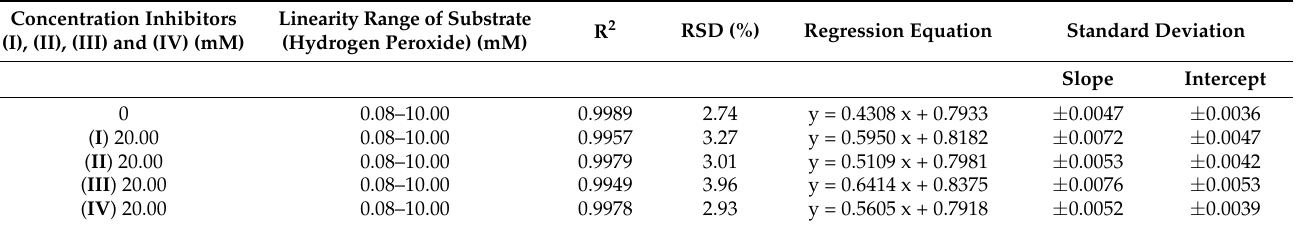
Figure 2. Representative electrophoregrams of investigated compounds in the presence of (I), (II), (III) and (IV) CAT inhibitors at the concentration of 20.00 mM, hydrogen peroxide at the concen- tration of 10 mM and (1) 20.00 mM of guaiacol (GCOL), (2) tetraguaiacol (TGCOL), (3) catalase (CAT). ( A ): (1) 11.71 mM of GCOL, (2) 8.29 mM of TGCOL ( • ) in the presence of inhibitor (III). ( B ): (1) 14.14 mM of GCOL, (2) 5.86 mM of TGCOL ( • ) in the presence of inhibitor (I). ( C ): (1) 15.61 mM of GCOL, (2) 4.39 mM of TGCOL ( • ) in the presence of inhibitor (IV). ( D ): (1) 17.56 mM of GCOL, (2) 2.44 mM of TGCOL ( • ) in the presence of inhibitor (II). ( E ): (1) 20.00 mM of GCOL, (2) 0.00 mM of TGCOL without inhibitors. Table 2. Regression equation and quantification for hydrogen peroxide for six replicates for each sample ( n = 6) in the concentration range 0.08–10.00 mM, in the presence of inhibitors (I), (II), (III) and (IV) at a concentration of 20.00